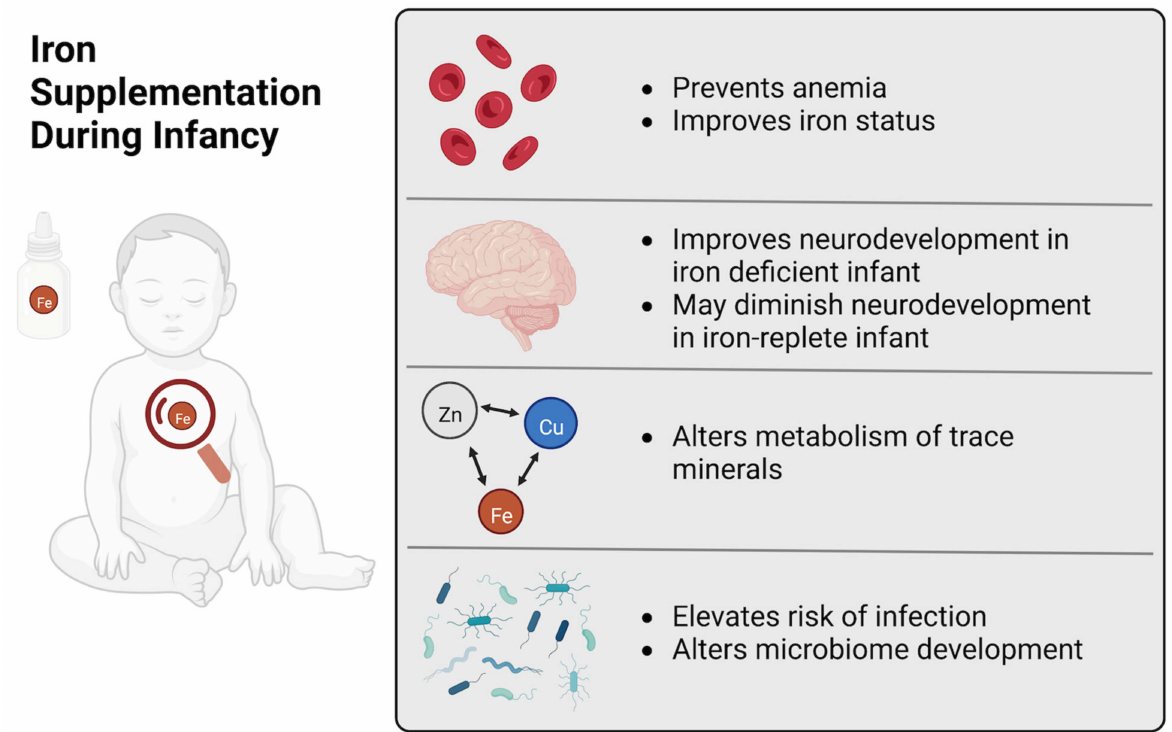
Figure 2. Iron Supplementation During Infancy. A graphical summary of the beneficial and adverse effects of iron supplementation of